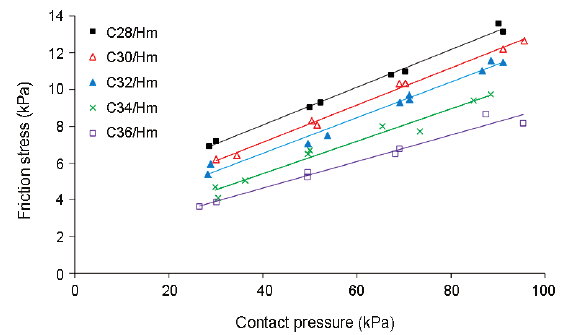
Fig. 20. Evolution of friction stress for